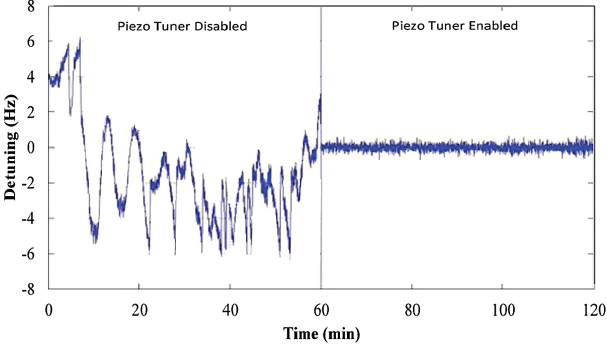
FIG. 31. Piezotuner control off and on (from